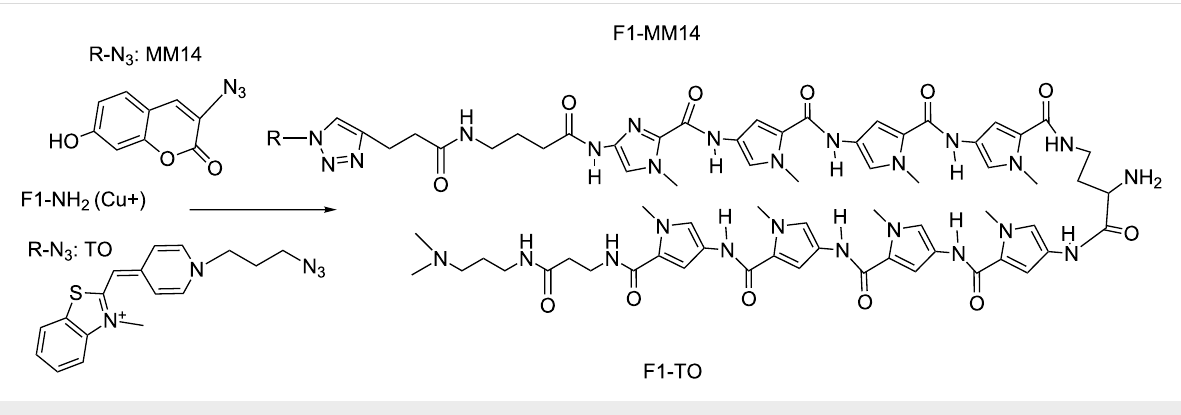
Figure 7: Structures of fluorescent probes synthesized by "click chemistry".